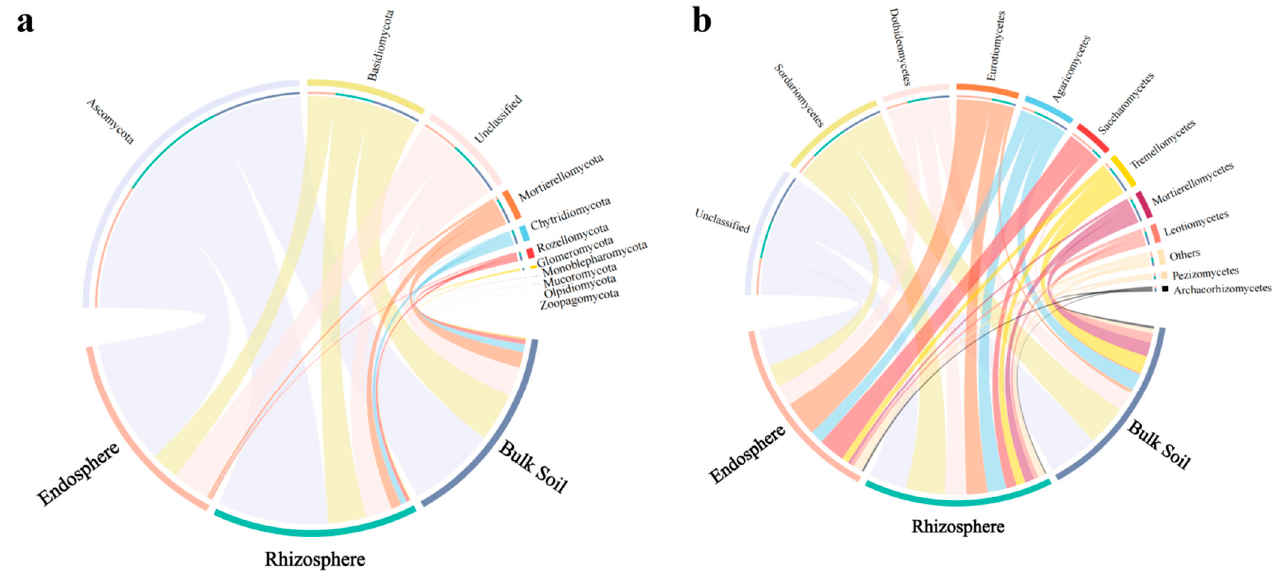
Figure 3. Relative abundance of fungi at the phylum ( a ) and class ( b ) levels in the various samples.